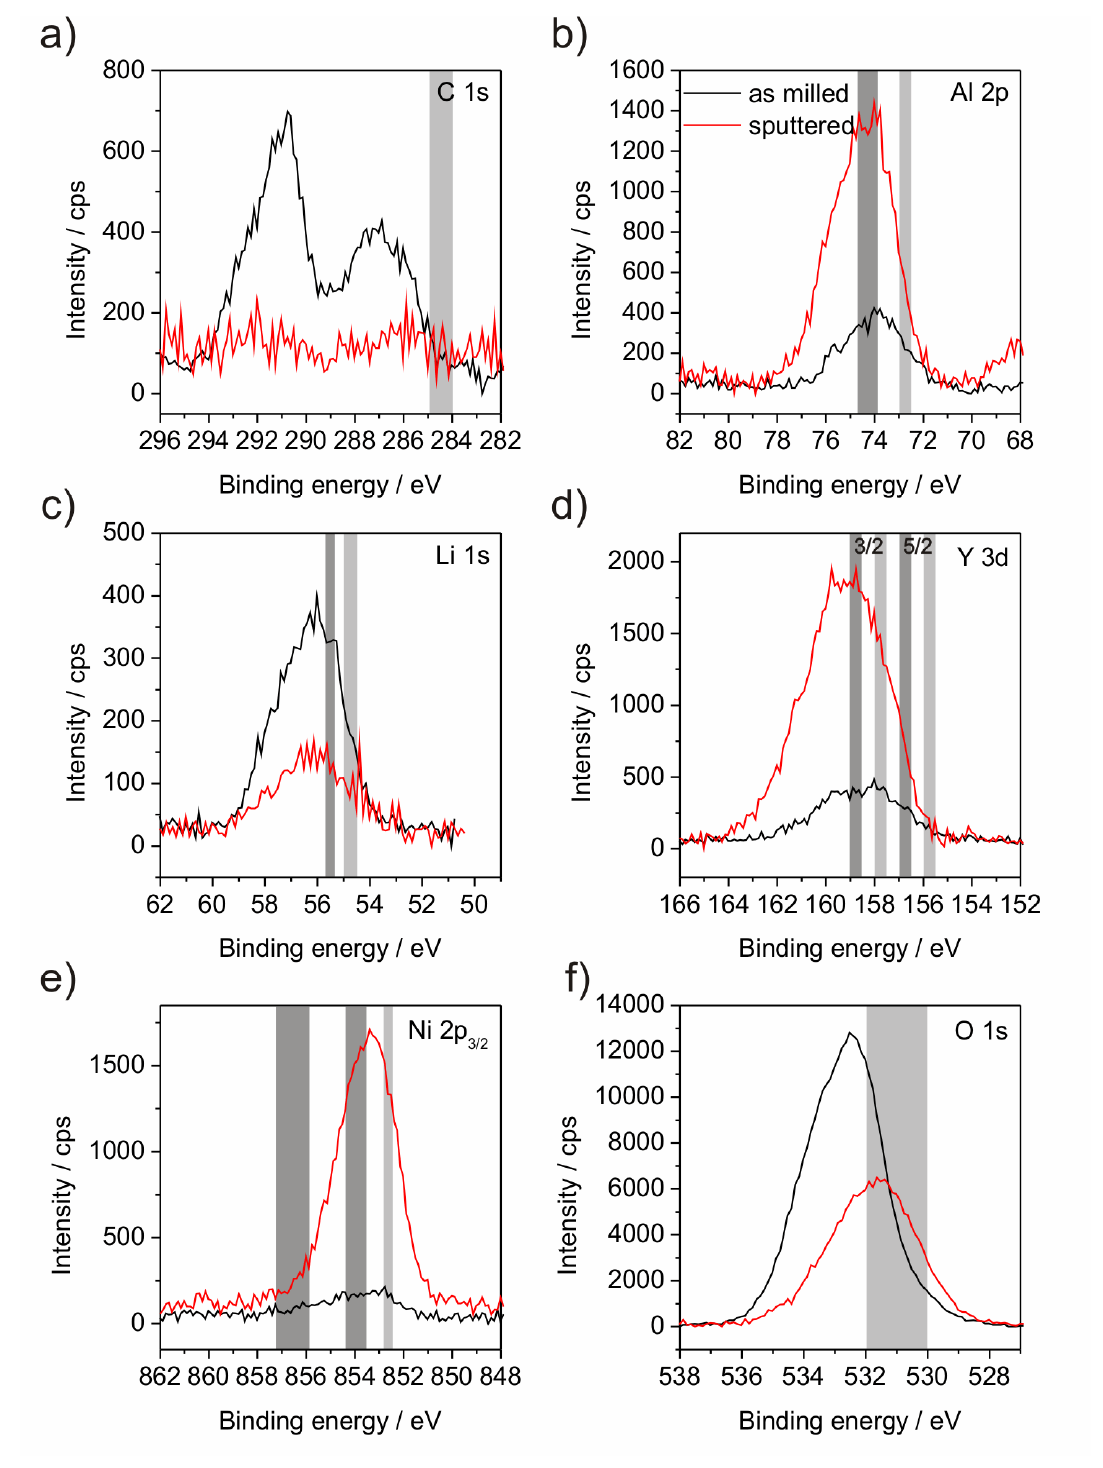
Figure 5. XPS diagrams of powder P2 including the binding energy lines of the elements C ( a ); Al ( b ); Li ( c ); Y ( d ); Ni ( e ) and O ( f ). The grey areas mark the theoretic energy ranges as referenced by Moulder et al. [24]. The right, light grey areas indicate the position of the elemental line; left positioned, dark grey areas indicate oxide